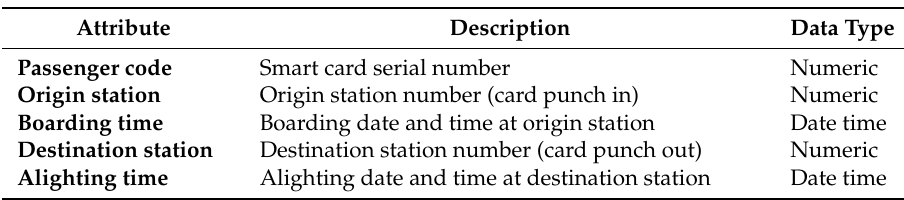
Table 2. Basic attributes of smart card transit data.